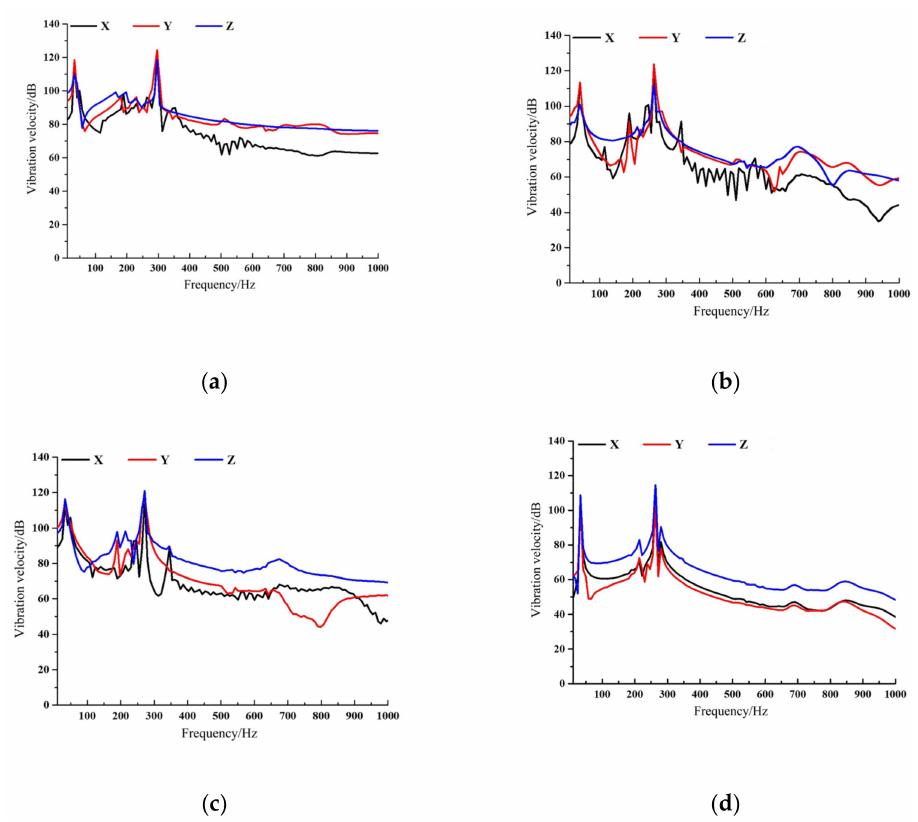
Figure 17. The frequency spectrum of the vibration of the pump unit caused by fluid excitation in impeller: ( a ) export flange; ( b ) import flange; ( c ) connecting plate; ( d )